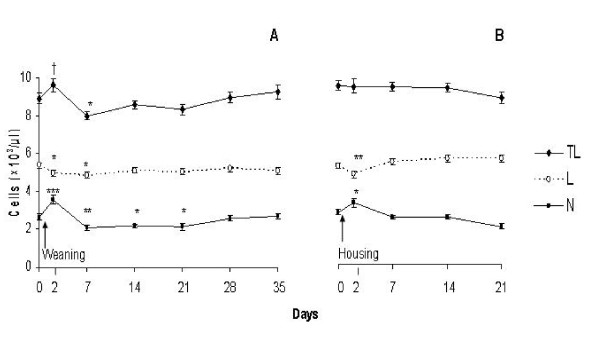
Effect of abrupt weaning and subsequent housing on total leukocyte, neutrophil, and lymphocyte number in beef cows. TL = Total leukocyte number, L = lymphocyte number and N = neutrophil number. Significant differences between d 0 (pre-weaning) and d 35 baselines (pre-housing) are denoted by asterisks; * = P < 0.05, ** = P < 0.01 and *** = P < 0.001. There was a tendency for a significant increase (P = 0.07) in total leukocyte number in beef cows at d 2 compared with d 0 and is denoted by †.